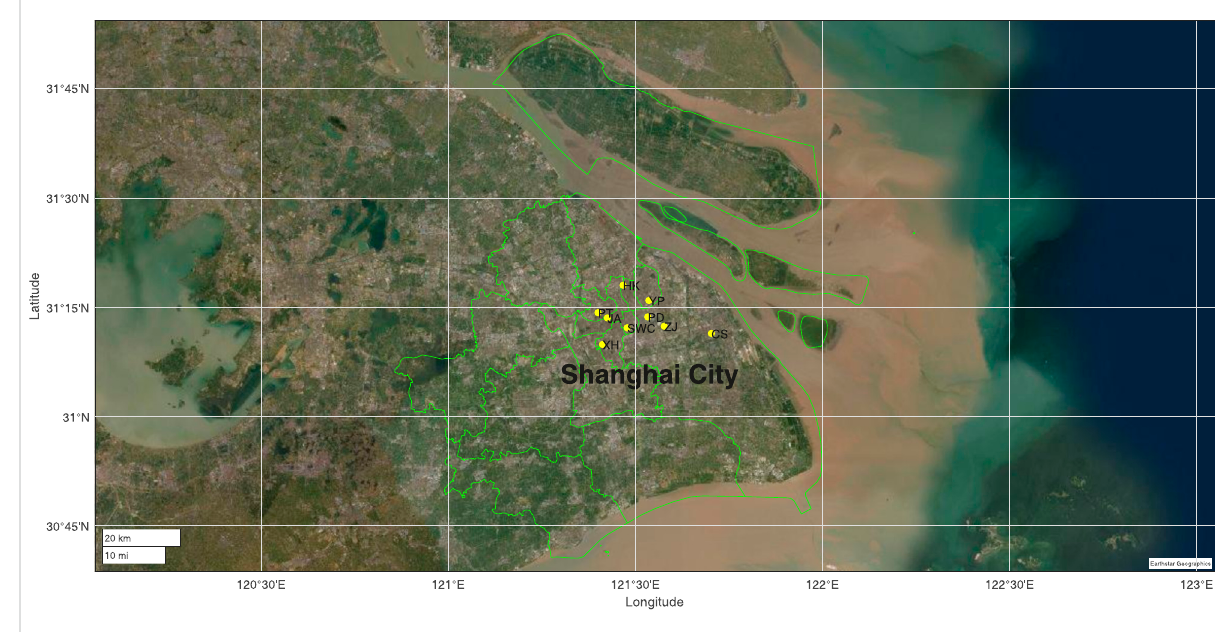
FIGURE 1 The detailed geographical distribution of 9 observational stations in the Shanghai region. The points in the fi gure represent the latitude and longitude of the Shanghai air quality monitoring station. Air quality monitoring station locations can be obtained from the website of Ministry of EcologyandEnvironmentofthePeople ’ sRepublicofChina(http://106.37.208.233:20035).Capitallettersinthe fi gurerepresentabbreviationsofsite